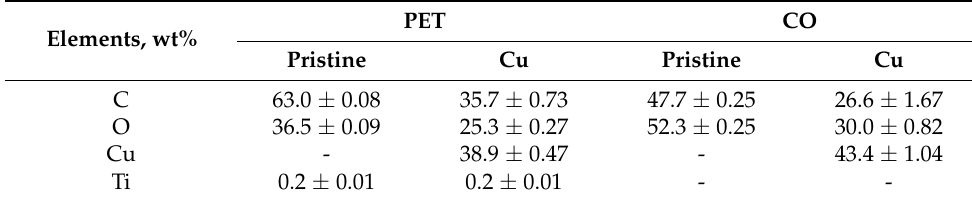
Table 3. Results of SEM/EDS analysis—weight percentage of elements. Elements, wt%